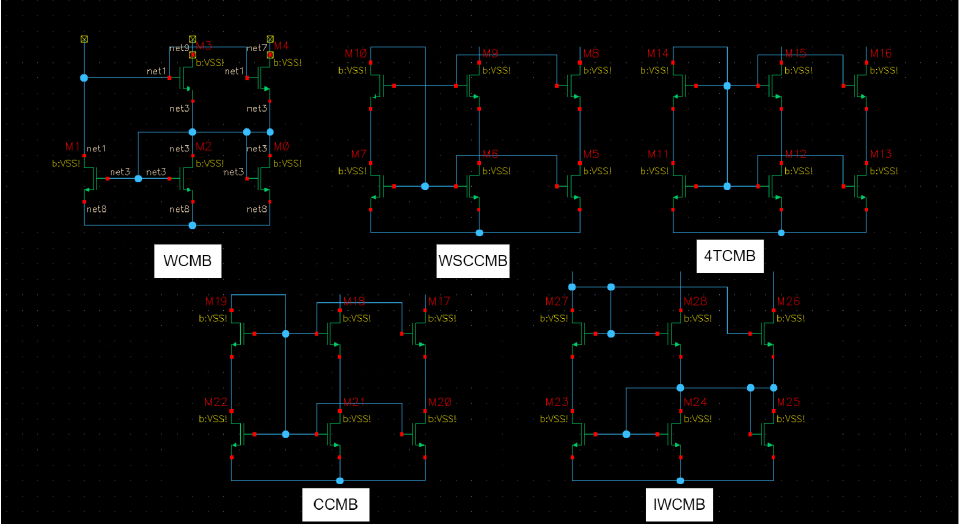
Figure 6. Five classes of current mirror banks to be classified: Cascode Current Mirror Bank(CCMB), 4 Transistor Current Mirror Bank (4TCMB), Wilson Current Mirror Bank (WCMB), Improved Wilson Current Mirror Bank (IWCMB), Wide Swing Cascode Current Mirror Bank (WSCCMB). Each one has an extra bank and the possibility to add more banks on the right side